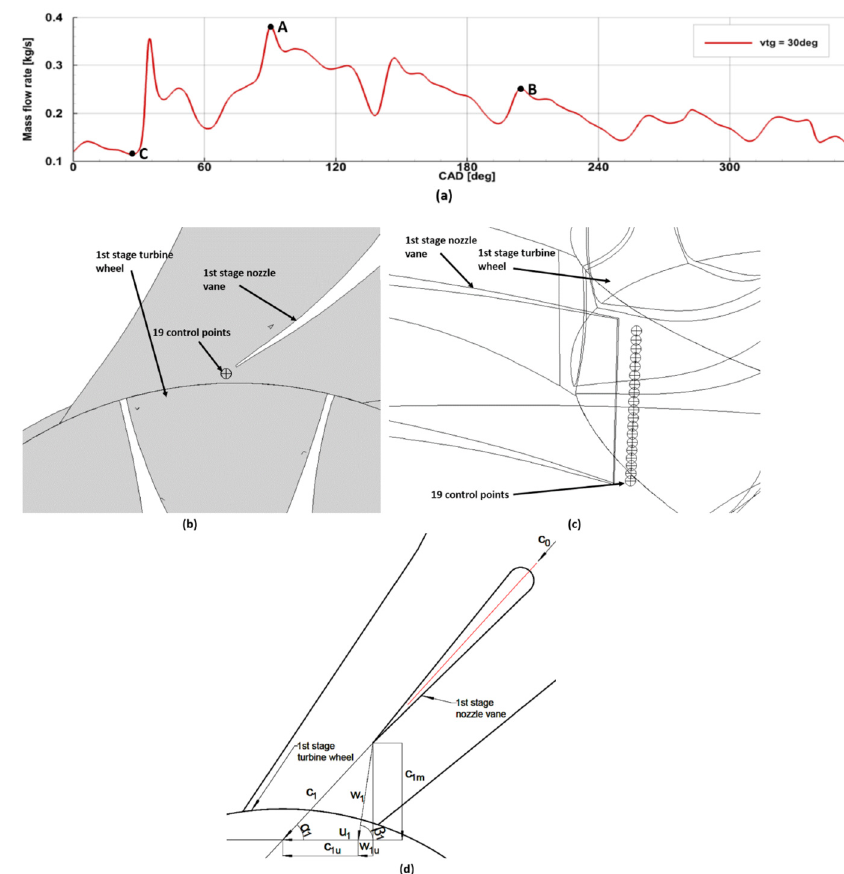
Figure 23. ( a ) The measuring points A, B, and C of the mass-flow rate at Section 6.1 of exhaust pipe 1, ( b , c ) the position of the control points at the trailing edge of the nozzle vane, ( d ) the velocity triangle at the outlet from the 1st stage nozzle vane of the exhaust pipe